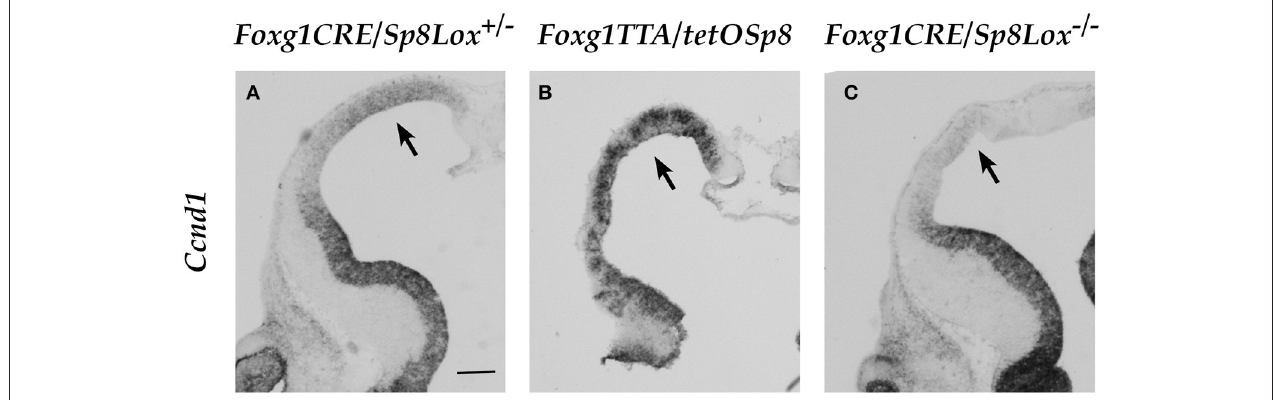
FIGURE 6 | Expression of Ccnd1 in embryonic forebrain after Sp8 misexpression in vivo . ISH on E12.5 mouse forebrain coronal sections. Arrow in Panel (A) shows Ccnd1 expression in the control pallial VZ. Arrows in Panels (B,C) show Ccnd1 expression in the Sp8 GOF and Sp8 LOF pallial VZ respectively. Bar in (A) : 200 µ m.